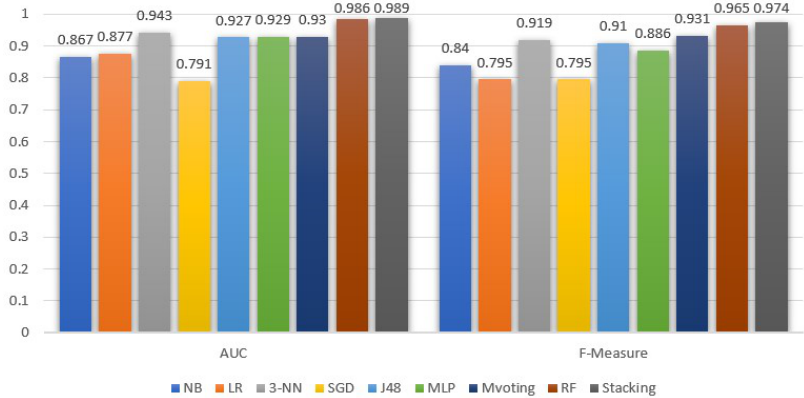
Figure 5. Machine learning models AUC and F-measure evaluation for the stroke class.